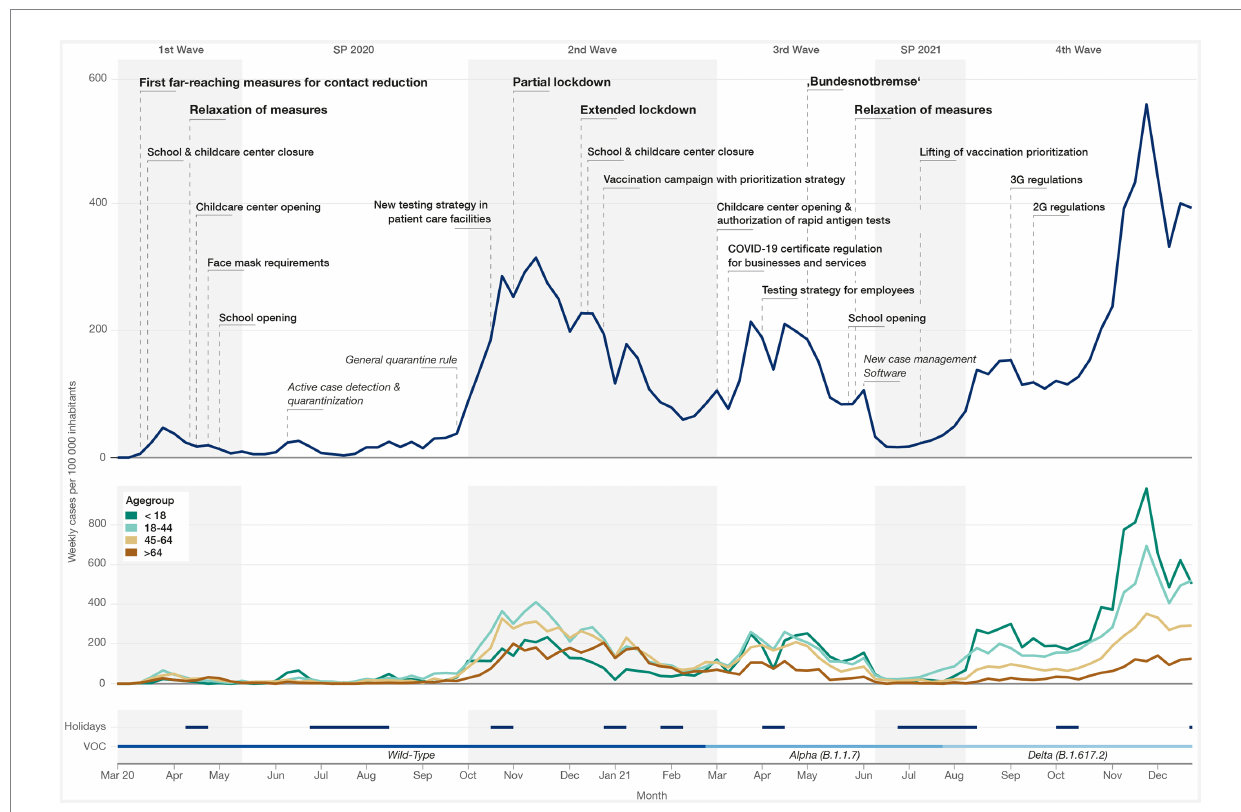
FIGURE 2 Development of incidence across pandemic phases, including the four waves and two summer plateaus (SP) during the study period. Top: incidence in Neukölln over time with far-reaching public health and social measures (bold), distinct measures/influencing factors (regular), and distinct measures/ influencing factors in Neukölln (italic); middle: age group-specific incidence; bottom: school holidays and variant of concern (VOC). Detailed descriptions of each measure can be found in Supplementary Table